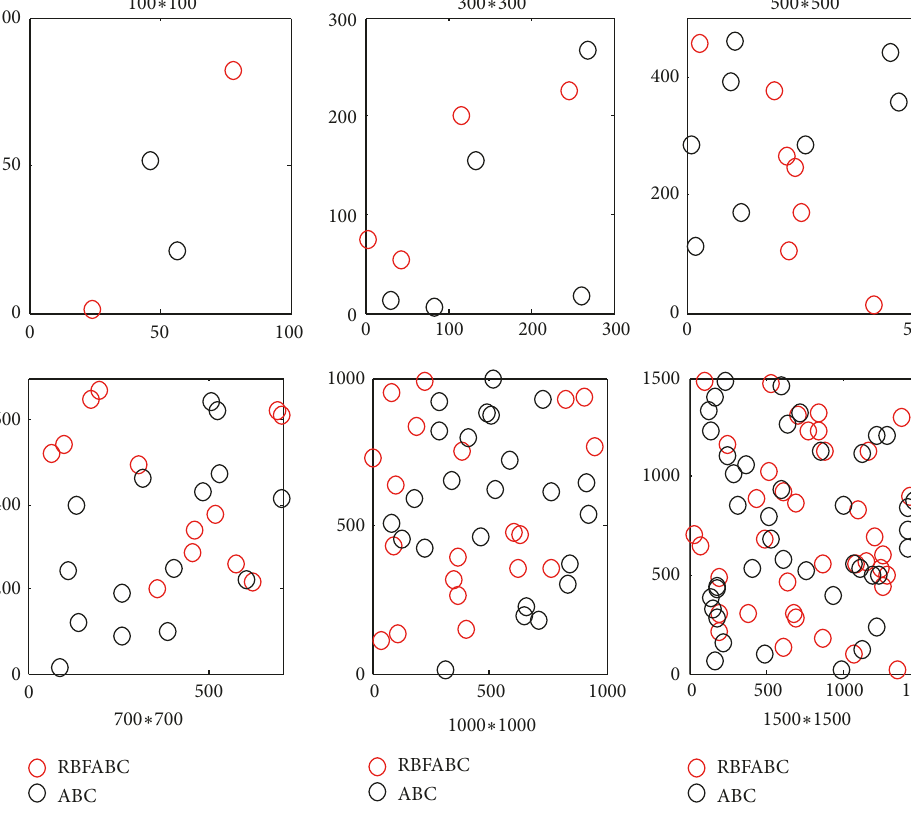
Figure 2: Node distribution under the same